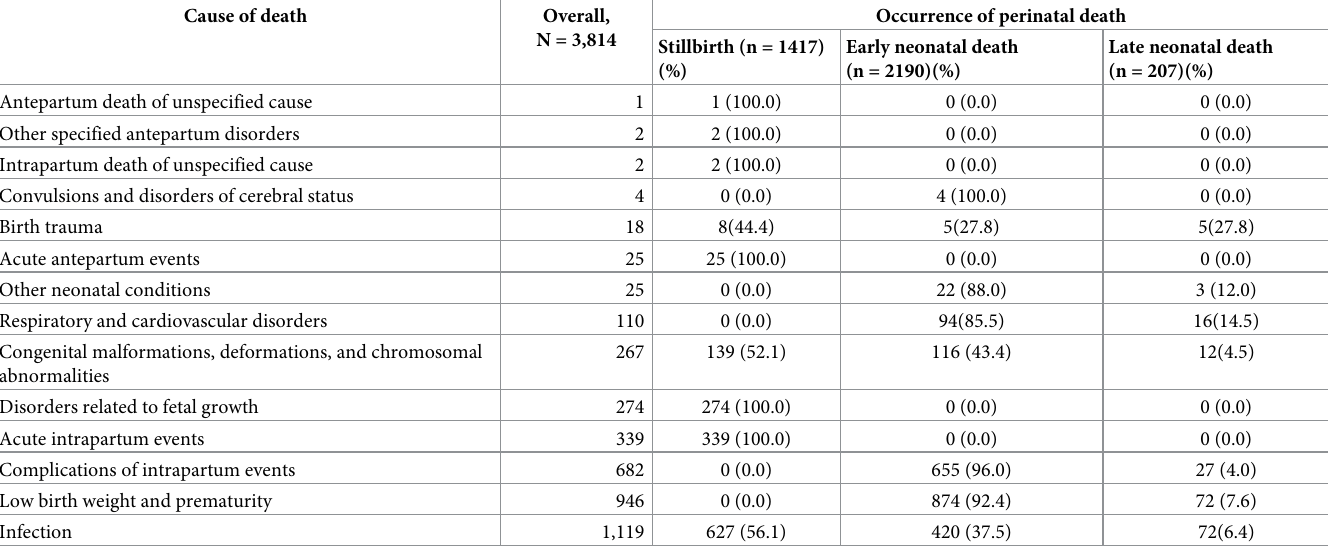
Table 7. Assigned cause of death to the deceased perinate by the timing of death in